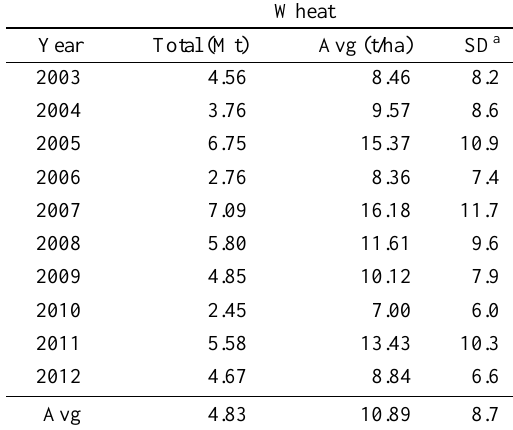
Table 5. Yearly estimation of total fuel load (Mt) and its average (t/ha) during wheat harvesting season.